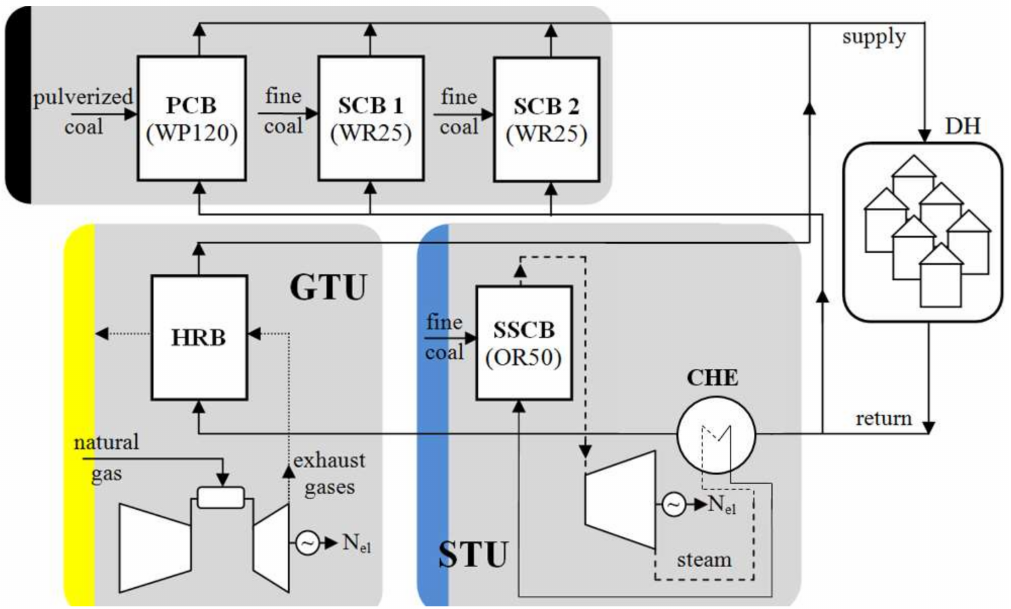
Figure 1. Schematic diagram of the current configuration of the analyzed district heating (DH) plant with heat and electricity